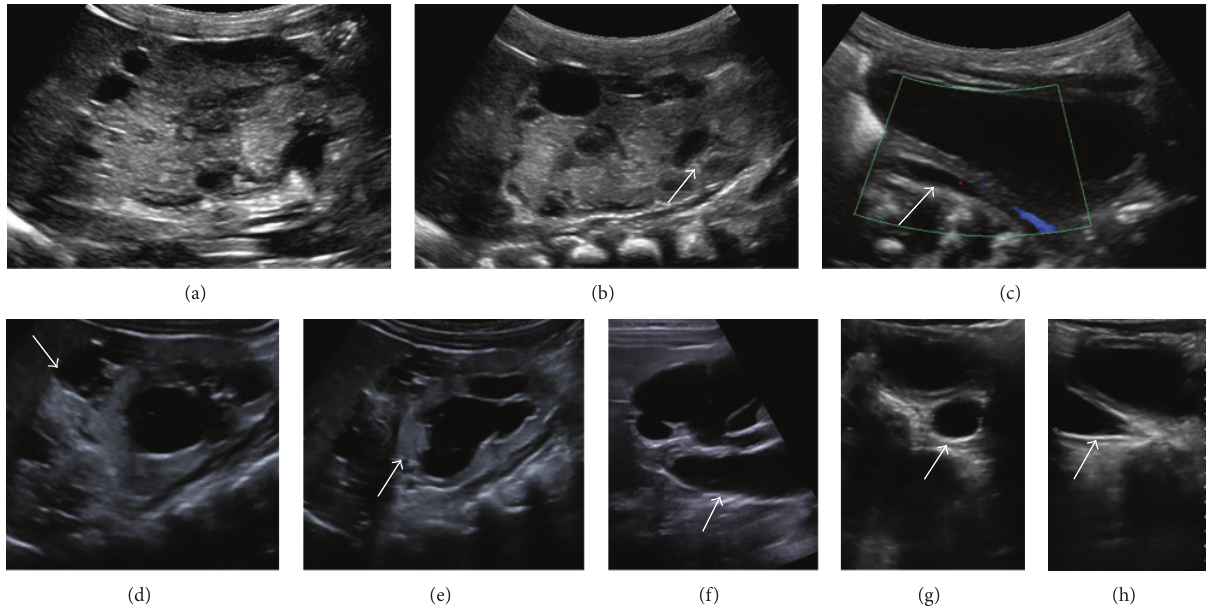
Figure 1: Abdomen US, day 0 of life (a)–(c). (a) and (b) sagittal images, solitary right kidney: cysts in the upper pole, increased renal parenchymal echogenicity, and mild dilatation of the renal pelvis (arrow); (c) right parasagittal image, bladder: mild dilatation of the right ureter extending to the ureterovesical junction (arrow). Abdomen US, 6 months of age (d)–(h). (d) sagittal image, right flank: noncommunicating cysts with no intervening renal parenchyma consistent with a right multicystic dysplastic kidney (arrow) and moderate hydronephrosis of the inferior crossed fused left kidney; (e) sagittal image shows increased renal parenchymal echogenicity of the crossed fused left kidney with relative preservation of parenchymal thickness (arrow); (f) sagittal image shows moderate dilatation of the proximal left ureter to the right of midline consistent with crossed fused ectopy; (g) transverse image, bladder: dilated distal left ureter confirms the crossed fused left renal ectopy; (h) sagittal image, bladder: dilated tapered atretic right ureter.